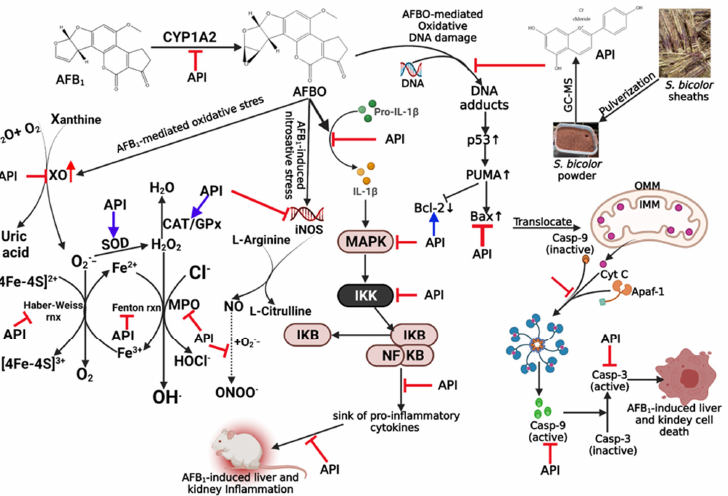
Figure 12. Proposed mechanism of SBE-HP ameliorative effect on AFB 1 -mediated toxicities in the liver and kidney of an experimental rat model. SBE-HP prevented AFB 1 -induced oxidative and nitrosative stress and inflammation by reducing the activity of CYP1A2, NF-kB-mediated generation of pro-in fl ammatory cytokines, and IL-1 β . SBE-HP also reduced apoptosis by altering the Bcl-2/Bax ratio favouring caspase 9 and caspase 3 activity. Created by h tt ps://app.biorender.com/ (accessed on 9 July 2022).